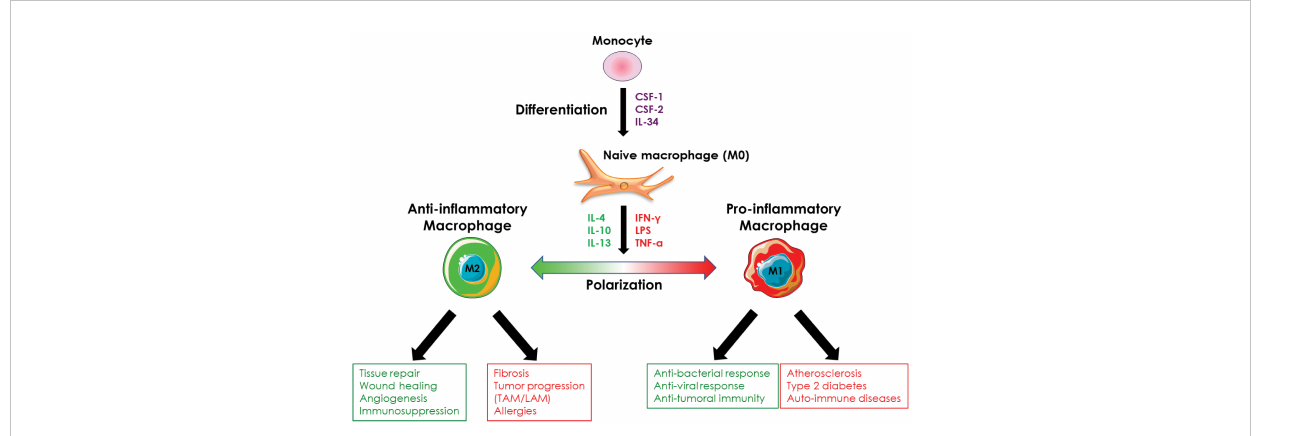
FIGURE 4 Macrophage polarization. Monocyte-derived-macrophages can be polarized ex vivo and in vivo into pro- or anti-in fl ammatory macrophages in response to different stimuli. Pro-in fl ammatory macrophages are involved in the anti-microbial and anti-tumor response and are implicated in the evolution of several pathologies such as atherosclerosis or type 2 diabetes. Anti-in fl ammatory macrophages exhibit an immunosuppressive activity, are involved in tissue repair, and promote angiogenesis. They are also involved in the evolution of various pathologies including fi brosis and tumor